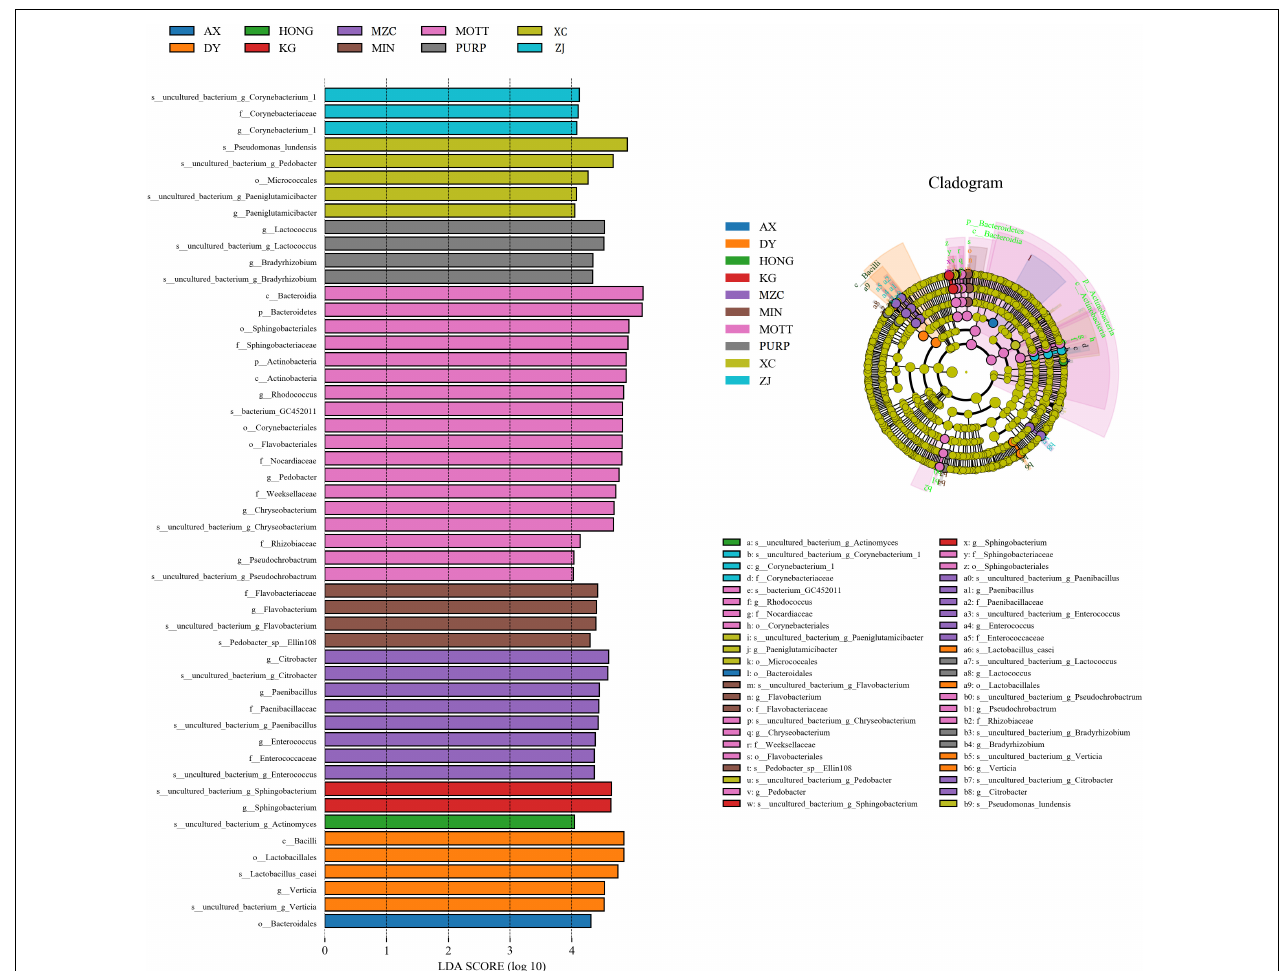
FIGURE 2 | Comparison of microbial variations in P. sinese silage using the LEfSe online